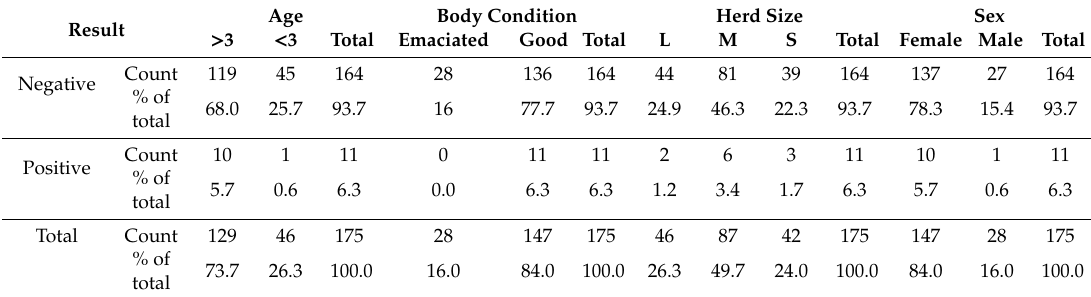
Table 2. Chi-squared test results for associations between cattle age, body condition, herd size, sex and prevalence of MAP antibodies in Khartoum